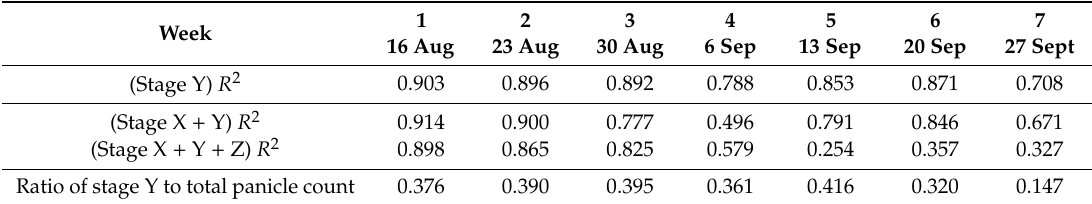
Table 3. Flowering intensity level per tree from pixel segmentation method and Y stage or all stages panicle counts, respectively, from the R 2 CNN(-rotated) method, and the average ratio of stage Y to total panicle count per image, for each week ( n =